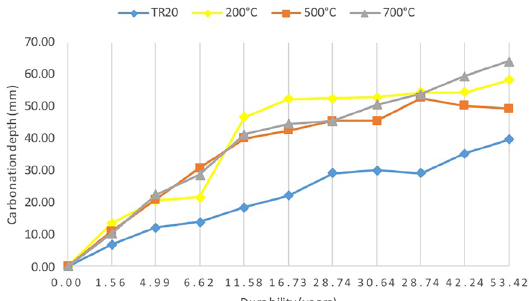
Figure 3. Carbonation depth versus durability for 20 MPa concrete quickly cooling.